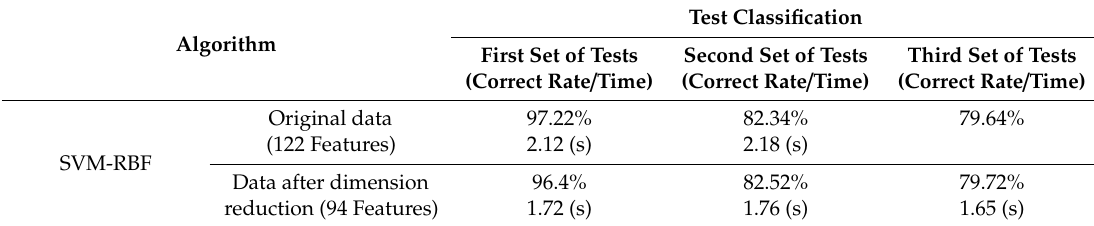
Table 6. Detection accuracy of the classifiers of the di ff erent